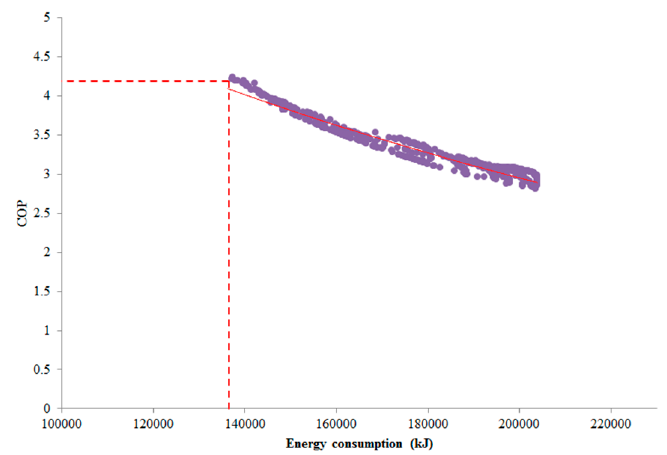
Figure 4. COP and energy consumption relationship in the GHP system.